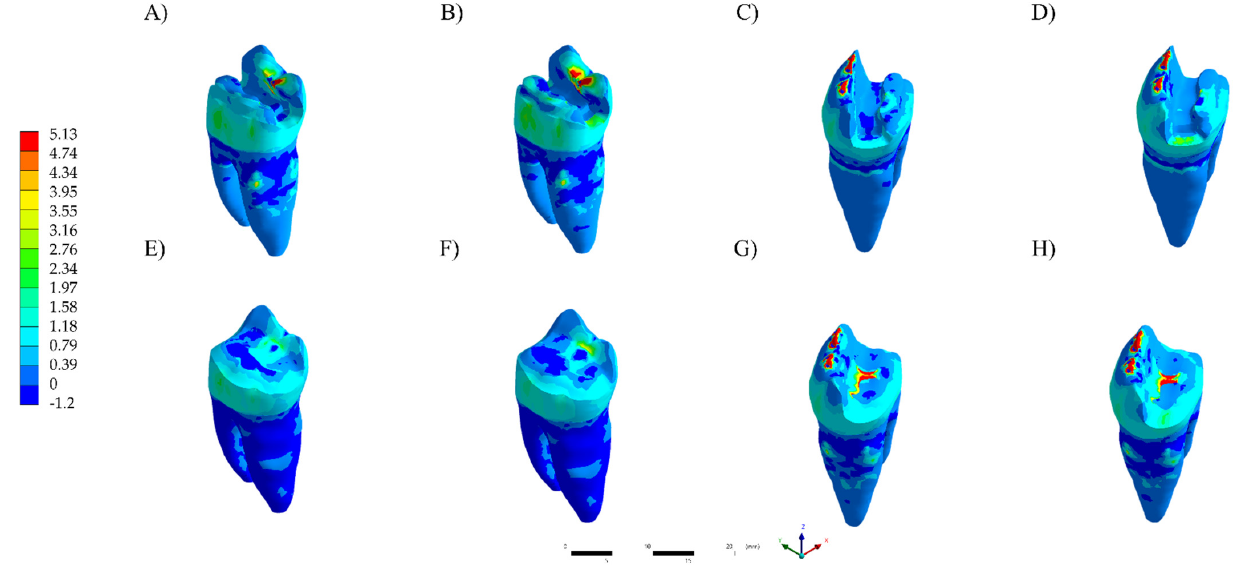
Figure 4. Maximum principal stress distribution in the tooth structure. ( A ) LD TFC. ( B ) RC TFC. ( C ) LD TNFC. ( D ) RC TNFC. ( E ) LD NFC. ( F ) RC NFC. ( G ) LD NNFC. ( H ) RC NNFC. Table 2. Stress peaks (MPa) measured for each geometry according to the preparation and restora- tive material combination.